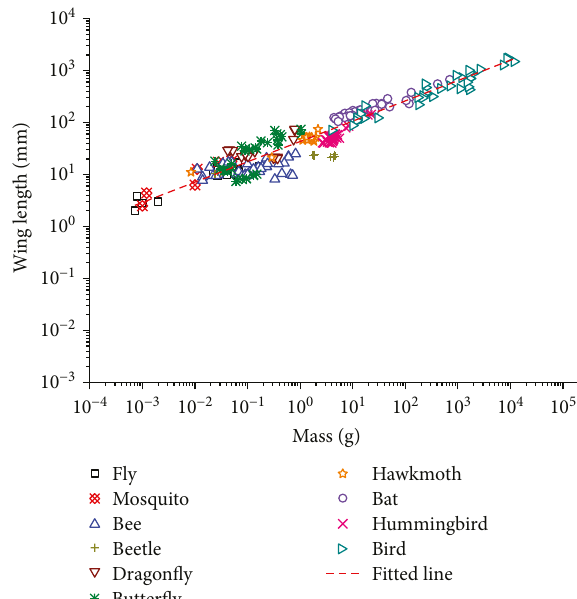
Figure 4: Relation of wing length vs.